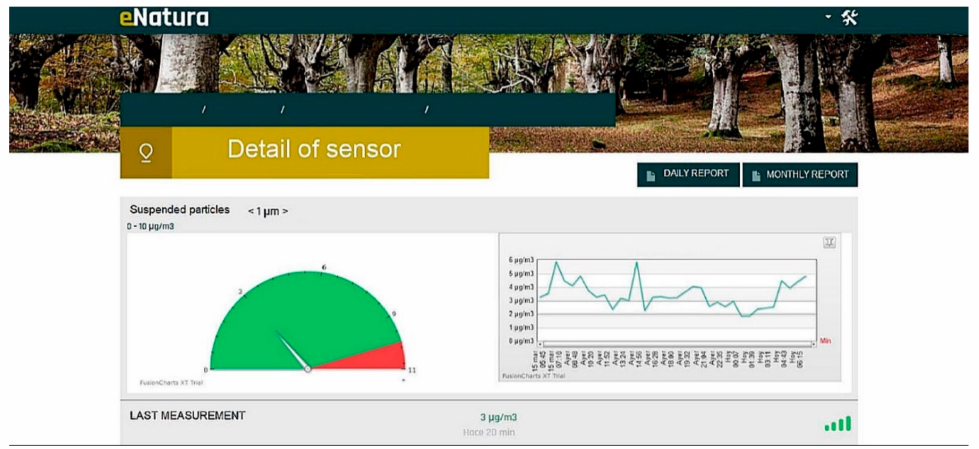
Figure 8. Image of the environmental parameter monitoring platform used in the construction of the Arnotegi